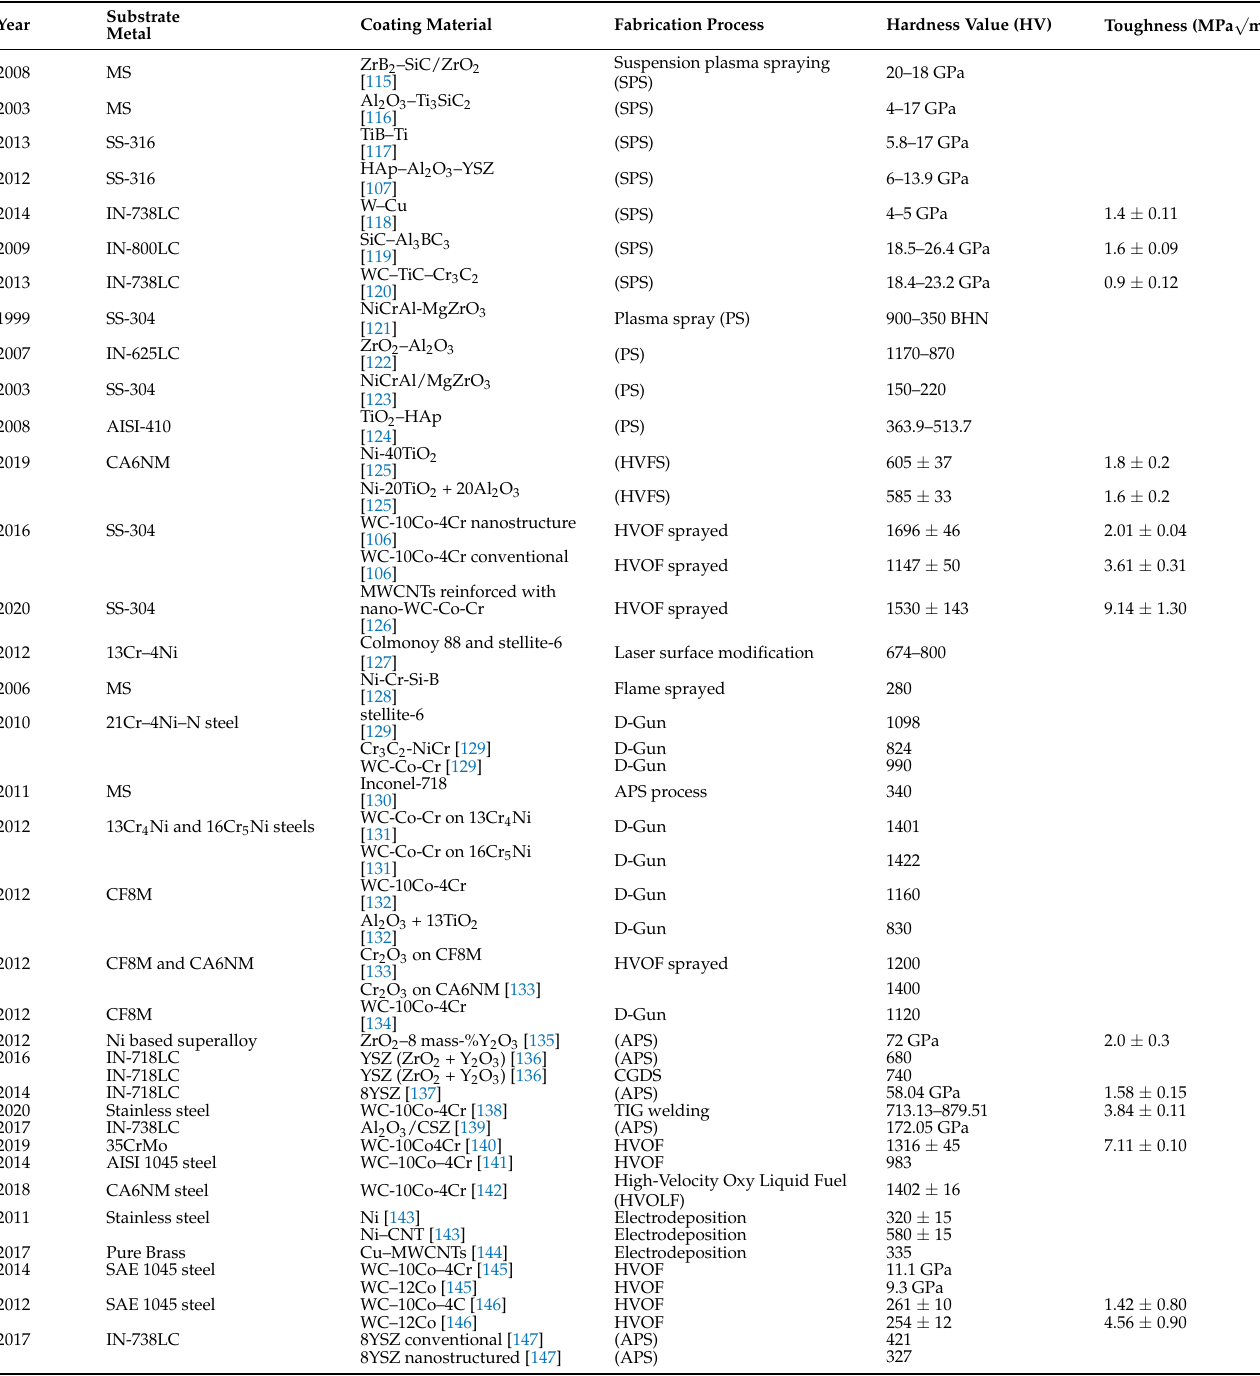
Table 4. Hardness and toughness values obtained from different coating materials in